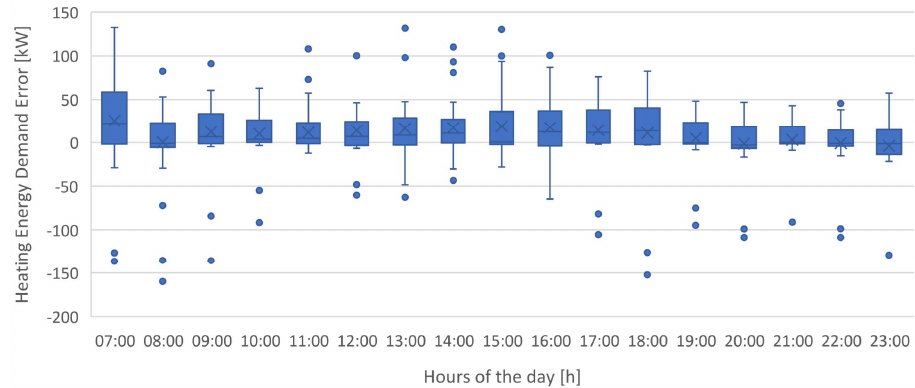
Figure 22. Heating energy demand error distribution for the test period using